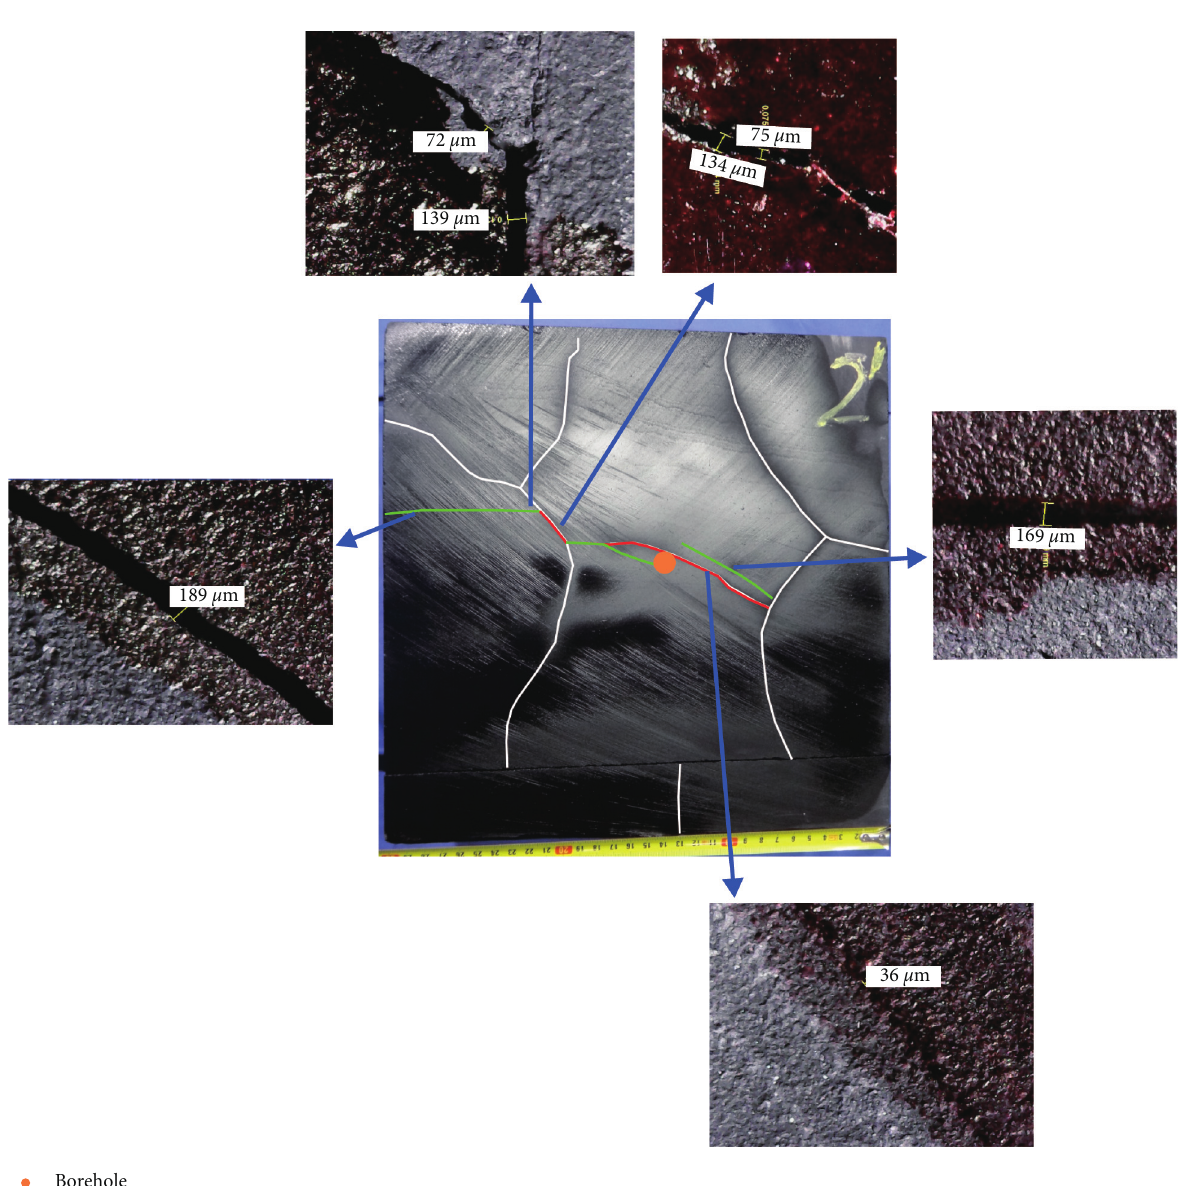
Figure 5: Various types of fracture of the shale specimens after hydraulic